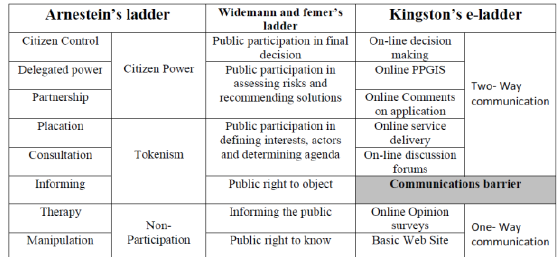
Table 1. Different ladder of participation (Metla,